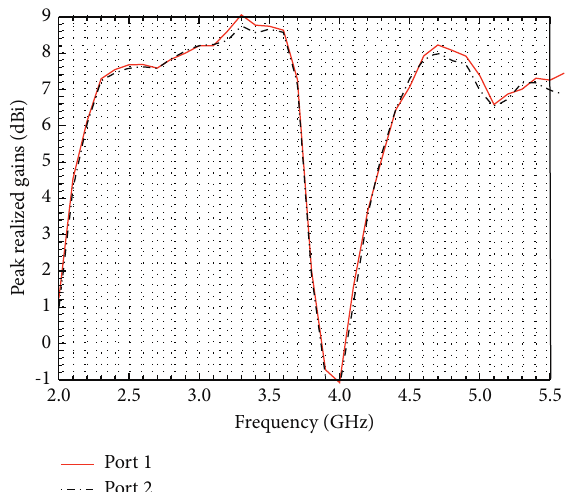
Figure 8: Measured peak realized gains of the proposed antenna.